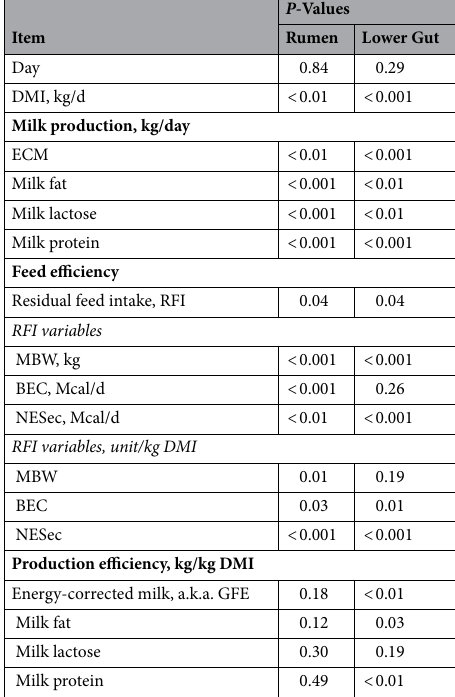
Table 1. Permutational multivariate analysis of variance (PERMANOVA) to test associations of production efficiency variables in first lactation Holstein